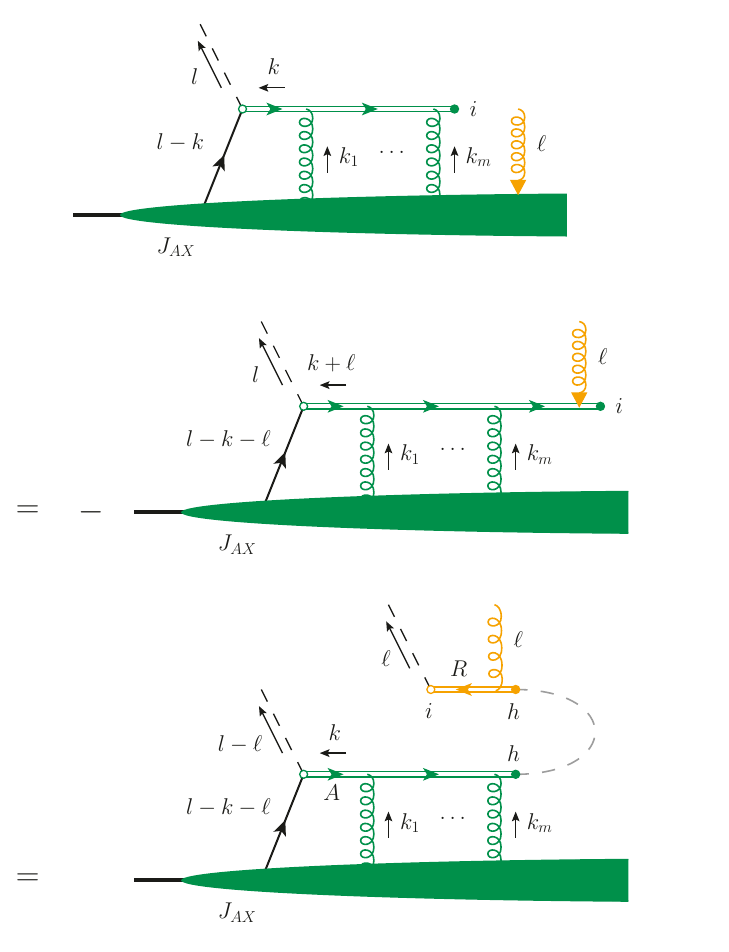
Figure 9 . Graphical representation for the decoupling of a single soft gluon from a collinear graph in the amplitude of an SPS process. In the last row, eikonal lines point along v A and v R as indicated. The dashed line between the two eikonal lines is drawn to visualise the contraction of colour